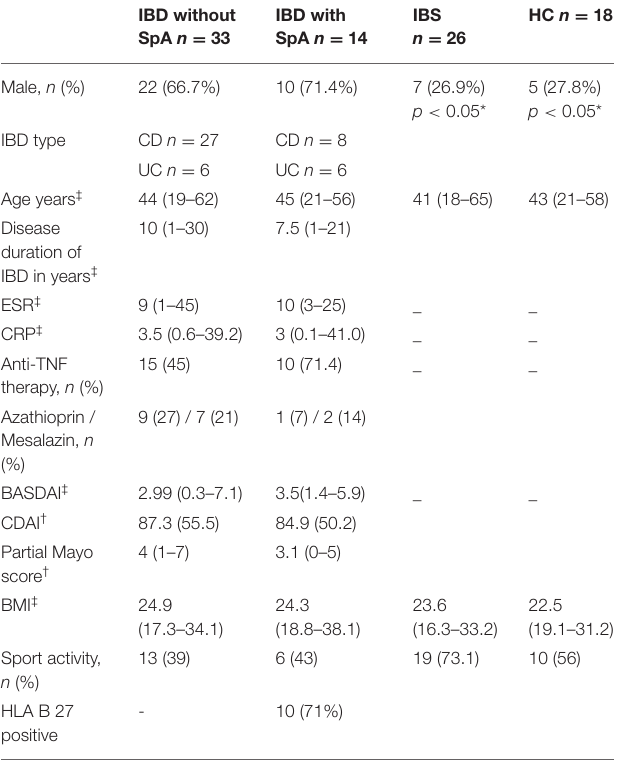
TABLE 1 | Clinical characteristics of IBD patients and controls. TABLE 2 | Distribution of ultrasound findings in IBD patients and control population (IBS and